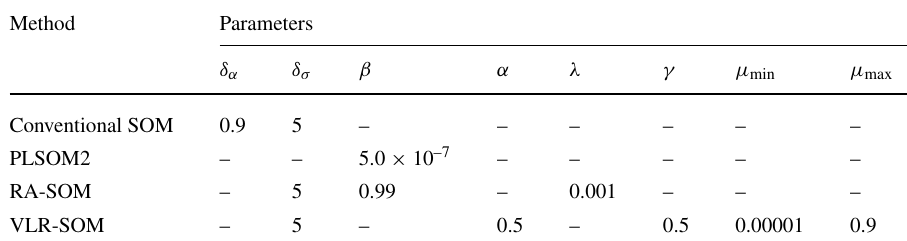
Table 1 Optimal parameters of random initialized map of a 2-dimension ( x , y ) ∈ [0, 1]